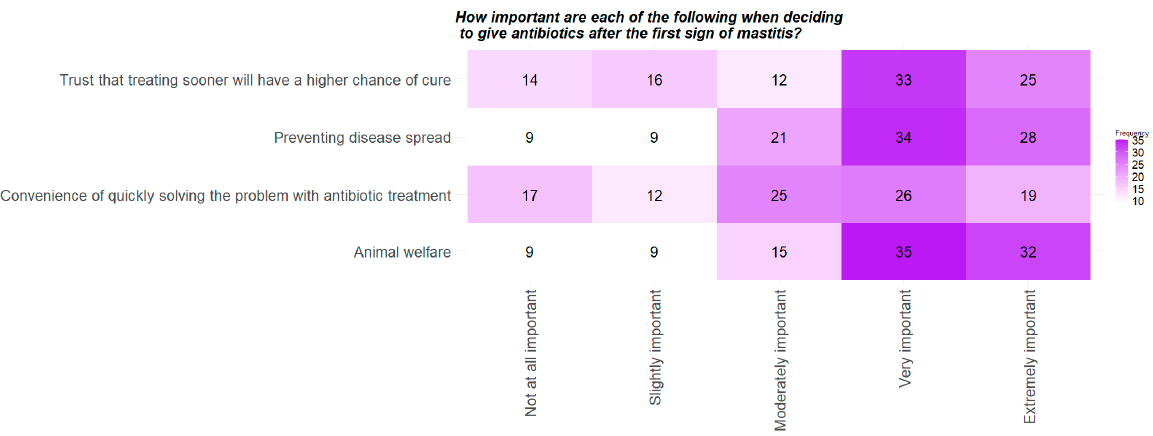
Figure 2. Heatmap of Q21, “How important are each of the following when deciding to give antibiotics at the first sign of mastitis?” Farmers ranked each factor individually along the scale from “Not at all important” to “Extremely important.” All farmers were displayed this question.